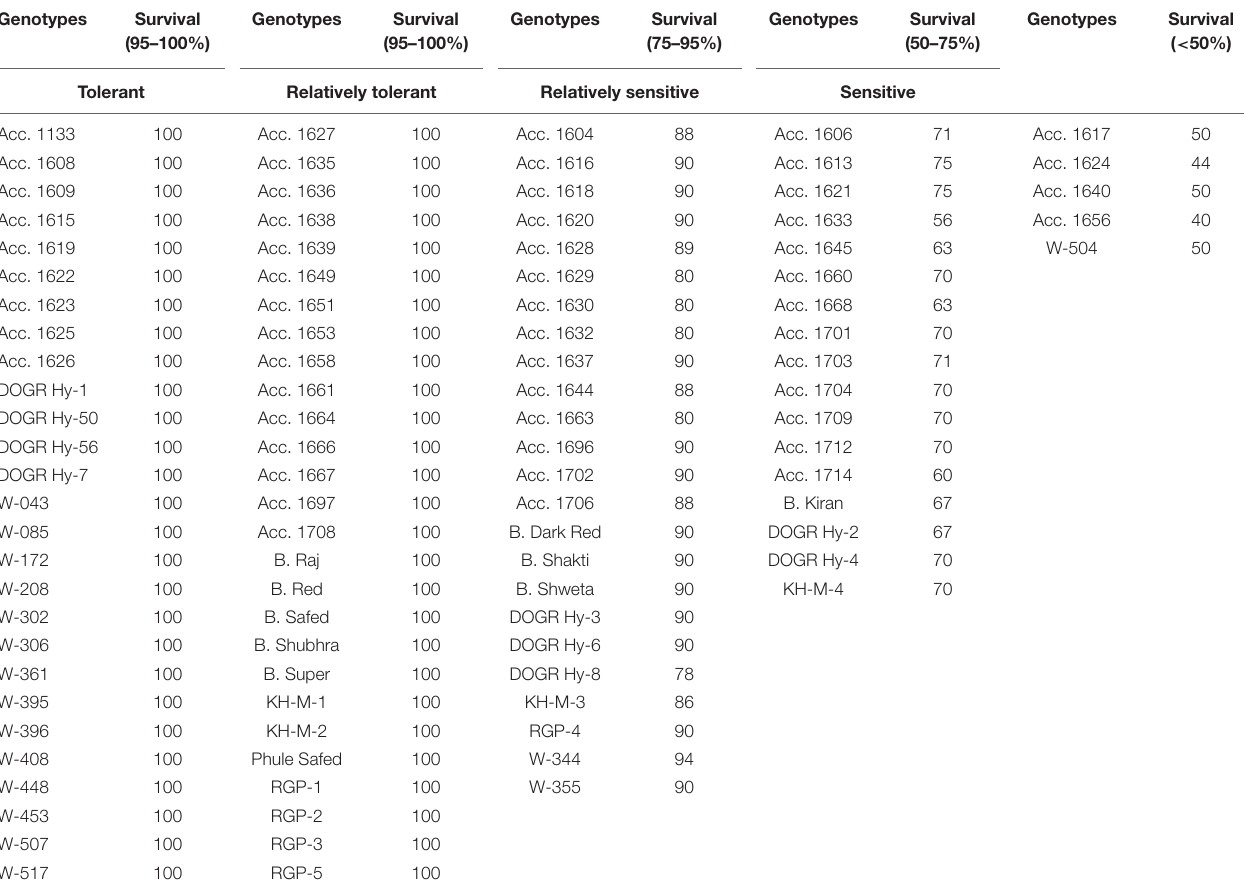
TABLE 1 | Genotypes grouped based on plant survival percentage under waterlogging stress. Genotypes Survival